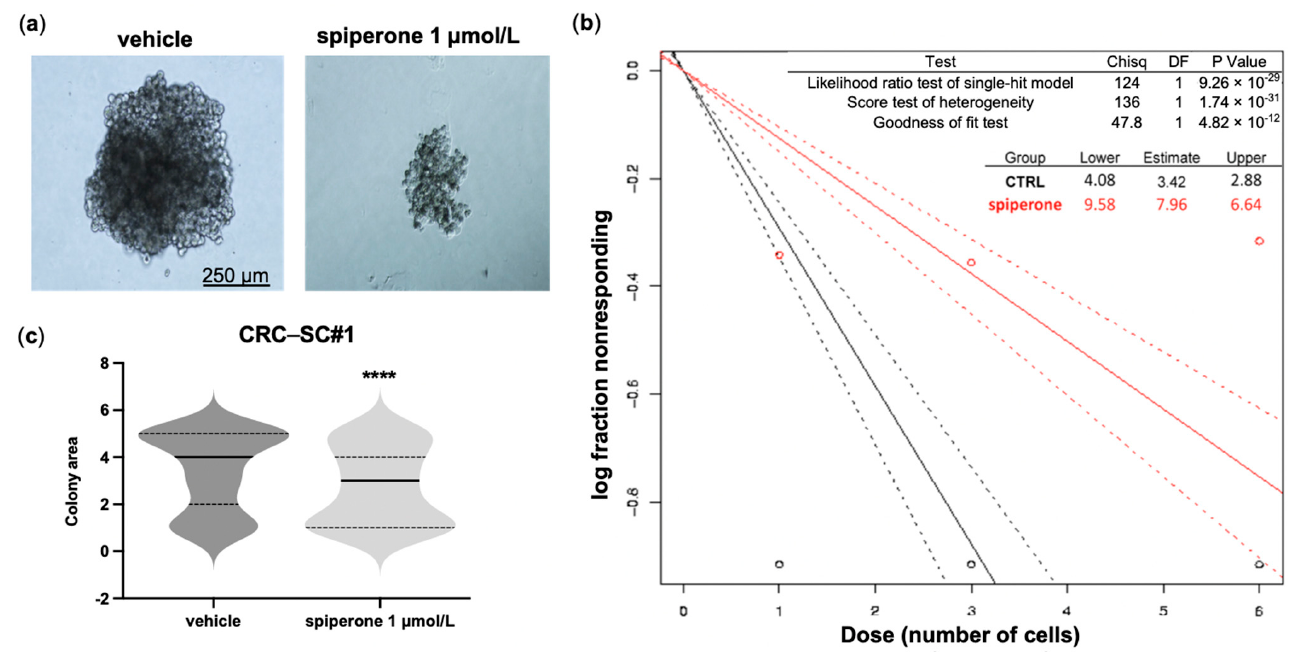
Figure 1. In vitro analysis of CRC-SCs’ self-renewal using the limiting dilution assay. CRC-SCs were dissociated to single cells and plated into 96-well plates. The number of wells containing spheres was then evaluated along with the size of each colonosphere. A sphere formation assay was performed on CRC-SC populations to evaluate their stemness and clonogenic potential. Representative image of CRC-SC#1 colonospheres (vehicle vs. treated) ( a ). Output of the ELDA software: the amount of initially seeded cells ( x -axis) is plotted against the log fraction of wells without any detected spheres ( y -axis). The slope of the line represents the log-active cell fraction ( b ). Distribution of colonospheres’ size (vehicle vs. treatment) ( c ). Data represent the mean ± SD from three independent experiments; ****: Student’s t -test p < 0.0001.